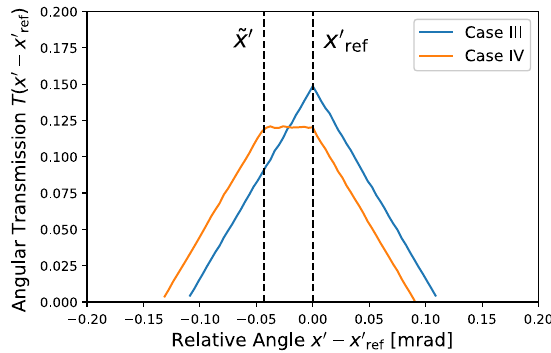
FIG. 16. Comparison between transmission ratio in Case III and IV when weight correction effect is